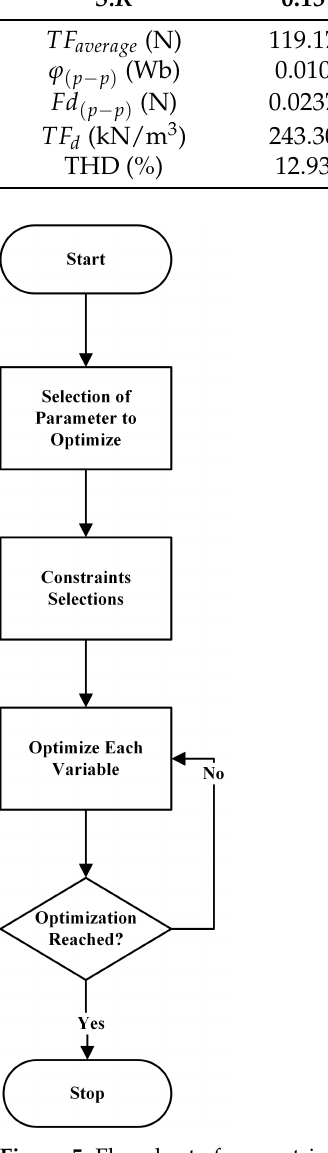
Figure 5. Flowchart of geometric optimization. The suitable height and width of the slot area are selected by keeping the overall slot area constant and changing the width and height of the machine. Increasing the width tends to decrease the height of the slot, and decreasing the width increases the height of the slot. The height and width of the machine are interrelated by Equation (6). Table 3 shows the thrust force profile at different slot width and height values. Table 3. Performance after geometric